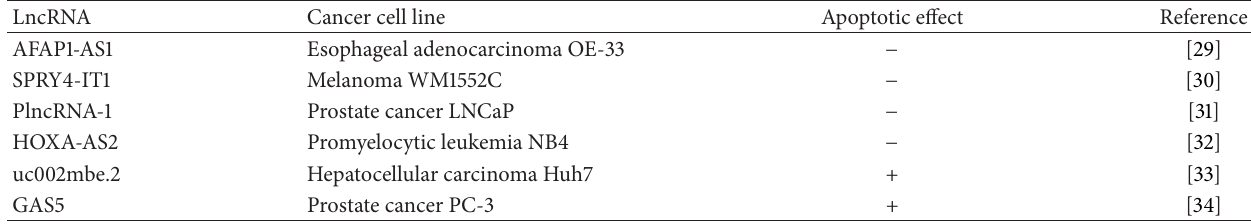
Table 1: LncRNAs involved in the regulation of apoptosis in cancer